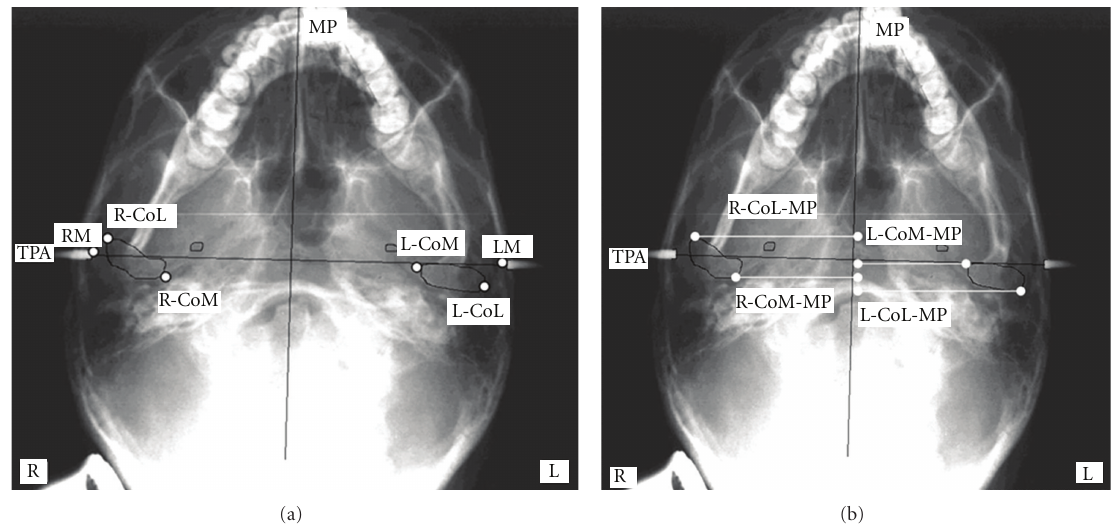
Figure 2: (a-b) Anatomic landmarks and reference planes used in submentovertex cephalometric analysis (Tracing 1). TPA, transporionic axis: line passing through the left and right tip of ear rods corresponding to the line passing through the midpoint of external auditory meatus (LM, left Mei; RM, right Mei); MP, midsagittal axis: perpendicular bisecting TPA; RCoL, right condylion lateralis: most lateral aspect of right condyle; RCoM, condylion medialis: most medial aspect of right condyle; LCoL, left condylion lateralis: most lateral aspect of left condyle; LCoM, left condylion medialis: most medial aspect of left condyle; RCoL-MP, right condylion lateralis-midline: distance from right L-point to MP; RCoM-MP: right condylion medialis-midline: distance from right M-point to MP; LCoL-MP, left condylion lateralis-midline: distance from left L-point to MP; LCoM-MP, left condylion medialis-midline: distance from left M-point to